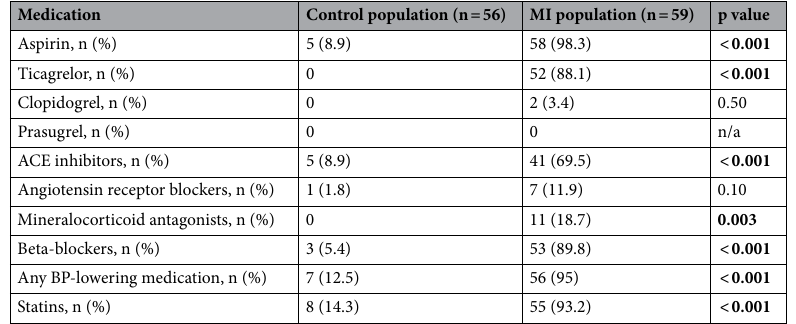
Table 2. Pharmacological therapy at the time of recruitment. Bold values are statistically significant (p < 0.05).